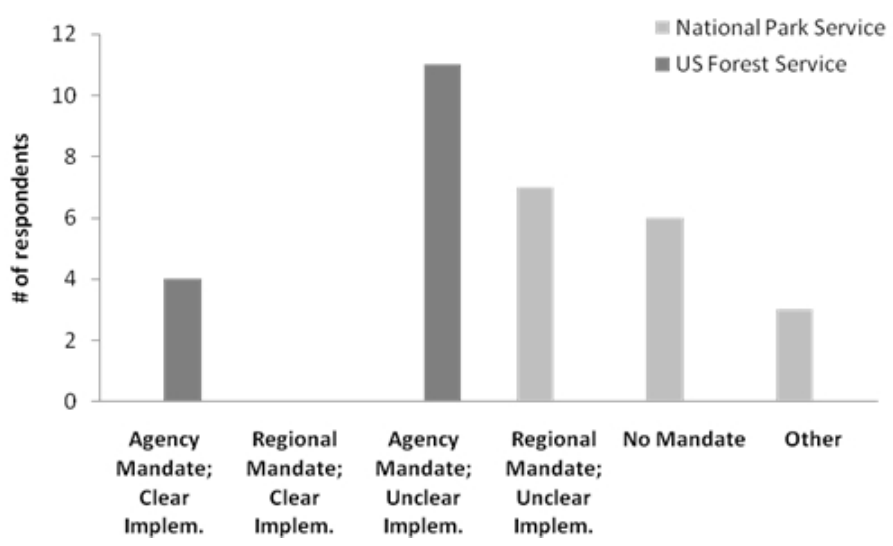
Fig. 2 . Interviewee responses regarding internal agency mandate to implement